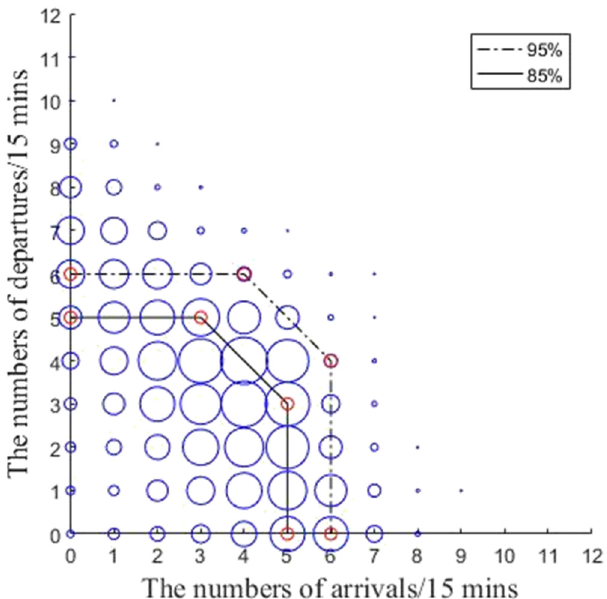
Figure 5: Operational throughput envelope within 15 min in the Urumqi